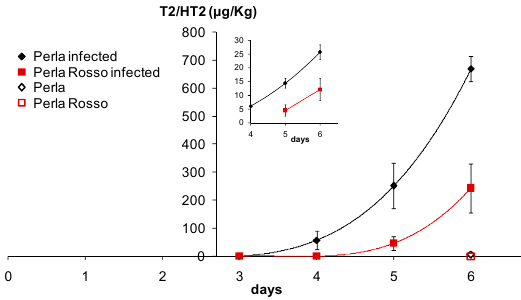
Figure 2. Accumulation of T-2/HT-2 toxins in dehulled caryopses of Perla (white caryopsis) and Perla Rosso (red caryopsis) incubated at 10 °C on agar in the presence of Fusarium sporotrichioides spores. Toxins were analyzed daily from three to six days after inoculation. Controls of dehulled caryopses without F. sporotrichioides spores were analyzed after six days only. ANOVA was therefore performed only on data of the last sampling day, showing a significant effect ( p < 0.05; n = 4–7 data for each mean/point) of both grain type (red/white), fungal treatment and their interaction. The main plot shows the original data, whereas the inset displays data >0 (for infected plates) transformed to the square root (on the y-axis). This transformed dataset was analysed by including sampling day as a covariate in ANOVA, which thereby showed a significant effect ( p < 0.001; n = 4–7 data for each mean/point) of both grain type (red/white) and sampling day.